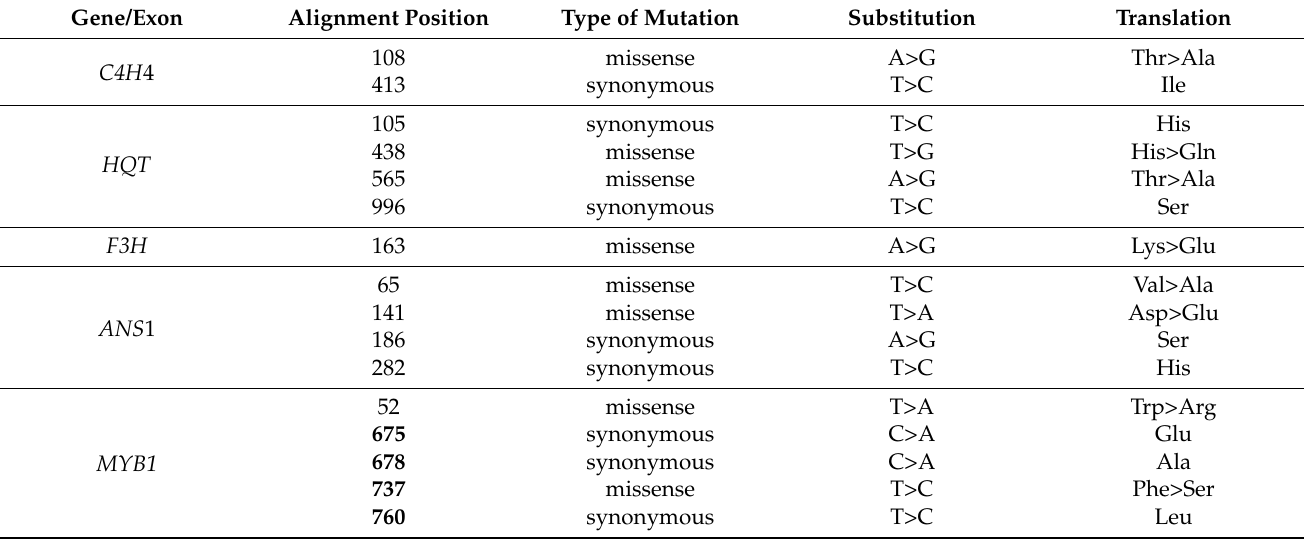
Table 3. Observed nucleotide polymorphisms in the genes studied. Those in bold represent poly- morphisms observed only in comparison with the reference sequence deposited in Kazusa Egg- plant Genome DataBase. Mutation types, nucleotide substitutions, and amino acid changes are also